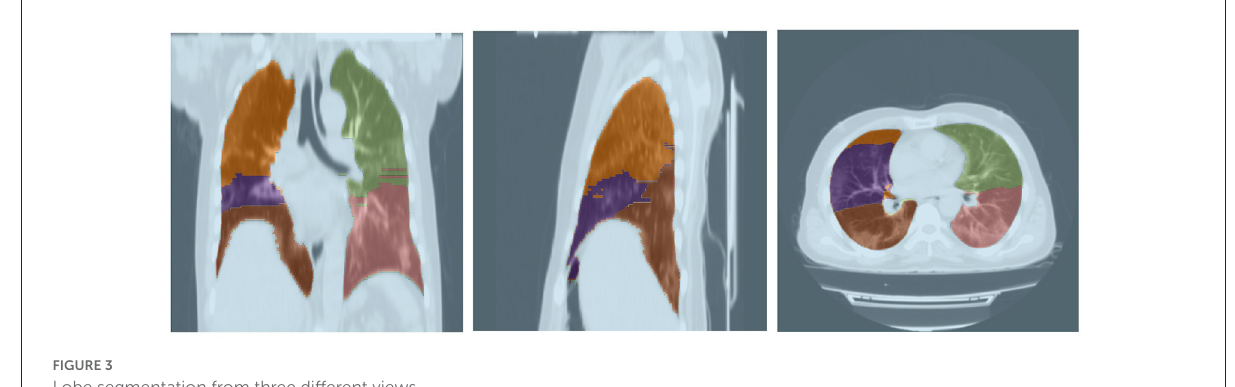
FIGURE3 Lobe segmentation from three different views.